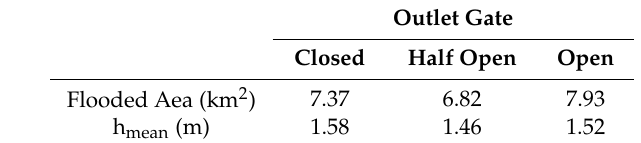
Table 3. Characteristics of the flood area downstream of Pianello, the initial water level in the reservoir is equal to 330 m a.s.l.